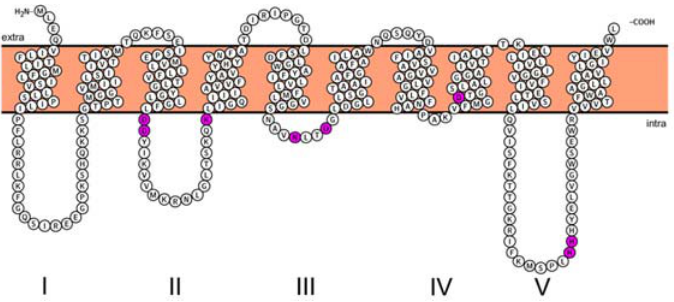
Figure 2. Topology maps of MraY from B. subtilis . Highly-conserved residues (D98, D99, K116, N171, D174, D231, H289 and H290) are highlighted in pink. The figure is rendered with the Protter web service [44]. Topology of other MraY species can be found in the Supplementary Information.